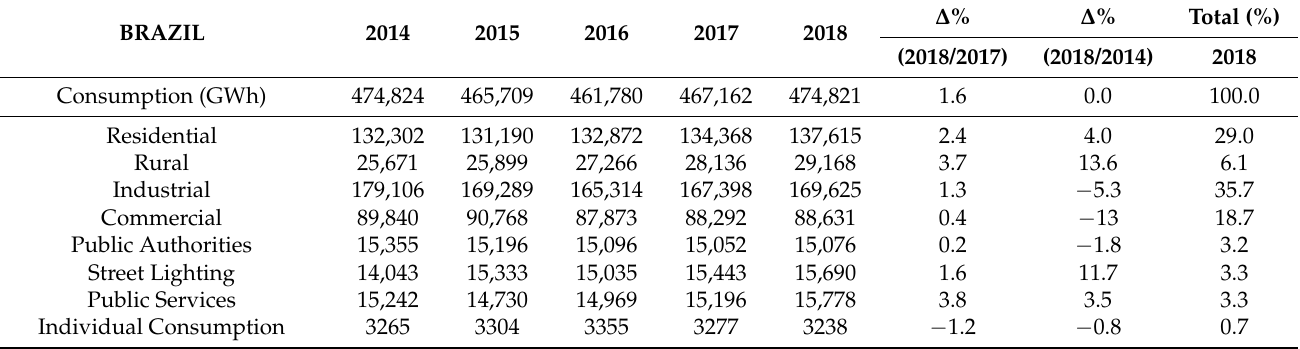
Table 1. Electricity consumption by consumer class—2014 to